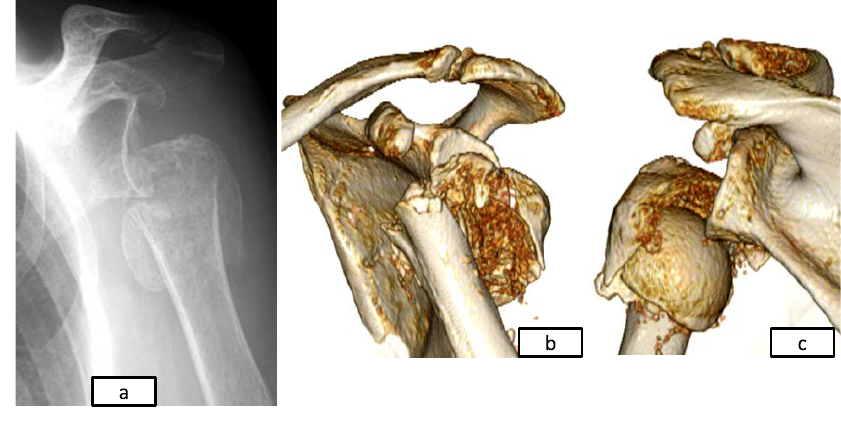
Figure 4 Case 2 : radiographic images The patient was an 86-year-old woman, with a Neer 4-part, group-6 fracture. a) X-ray and b,c) 3D CT images of fractures of the humeral surgical neck, and lesser and greater tubercle. The humeral head dislocated